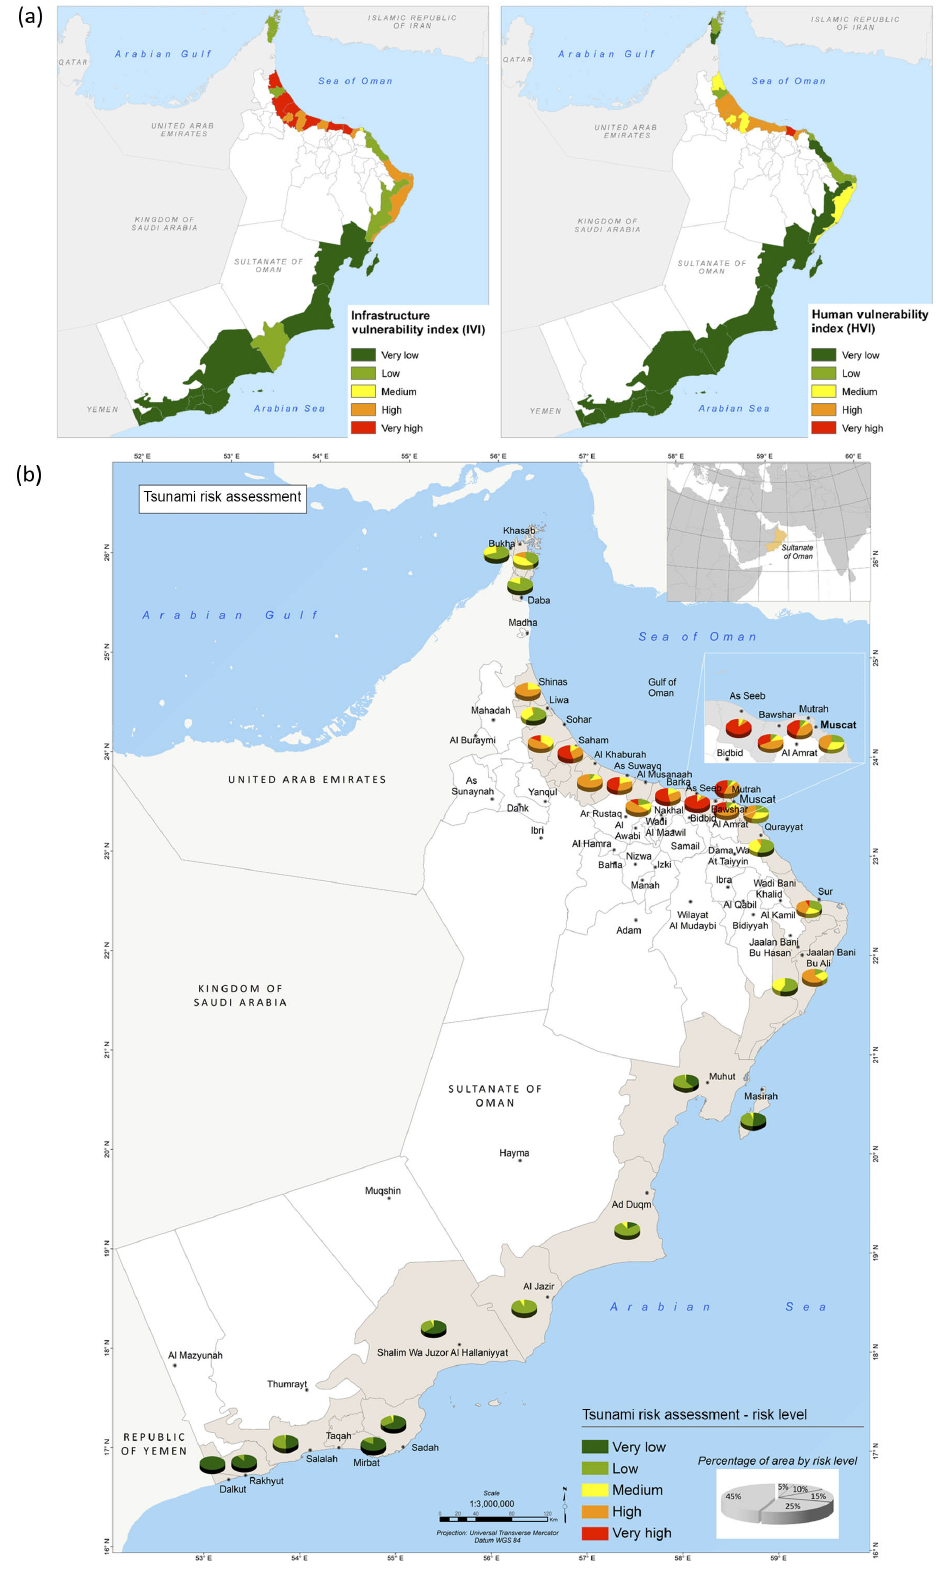
Figure 9. (a) IVI and HVI: infrastructure and human vulnerability indexes; (b) integrated tsunami risk assessment.